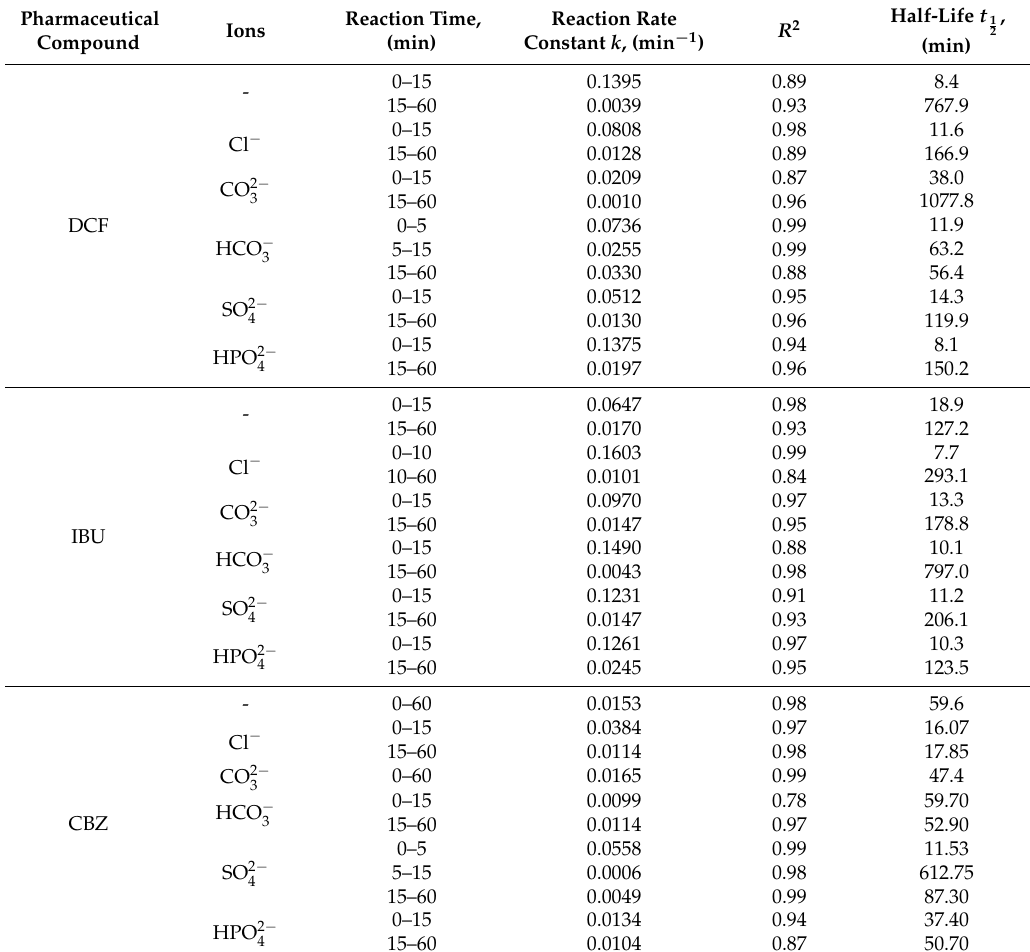
Table 3. Half-life of investigated pharmaceutical compounds during photocatalysis in the presence of selected